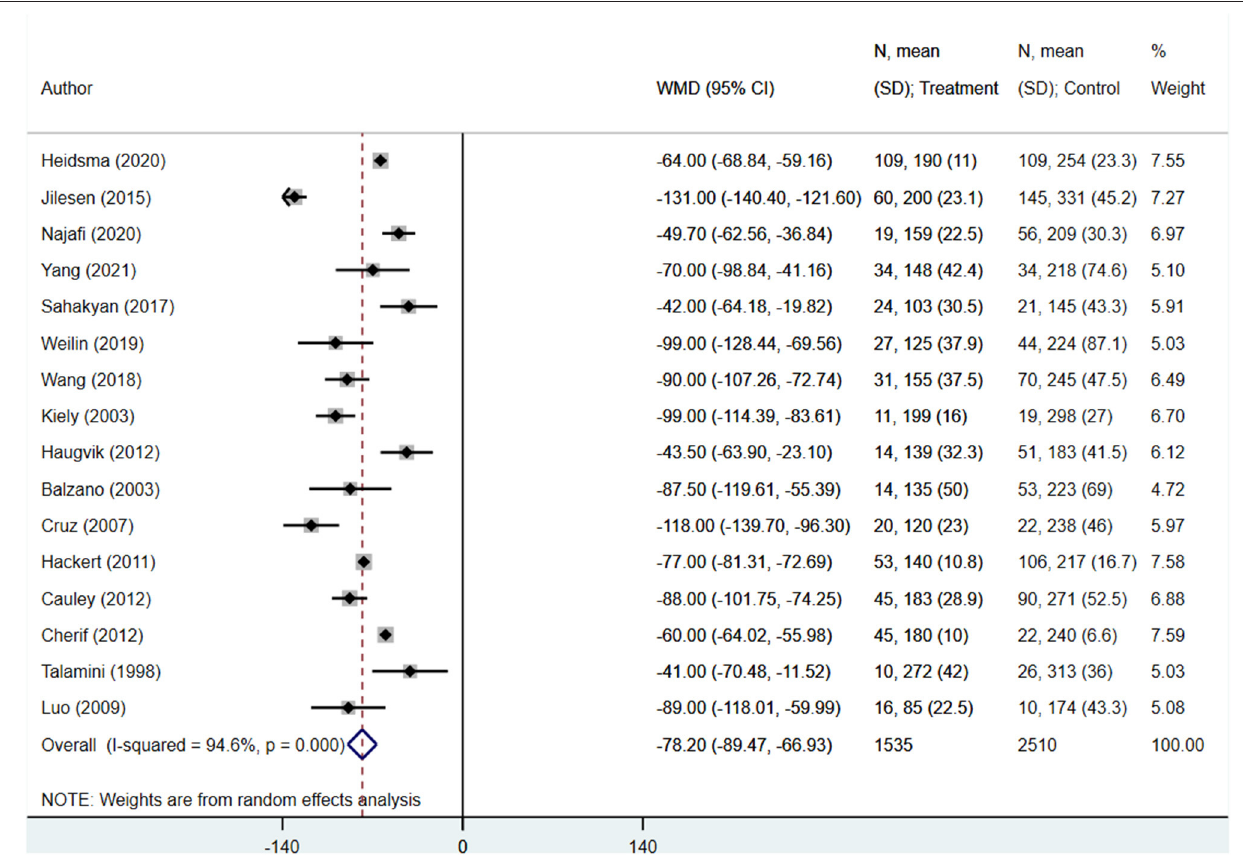
Frontiers in Surgery |